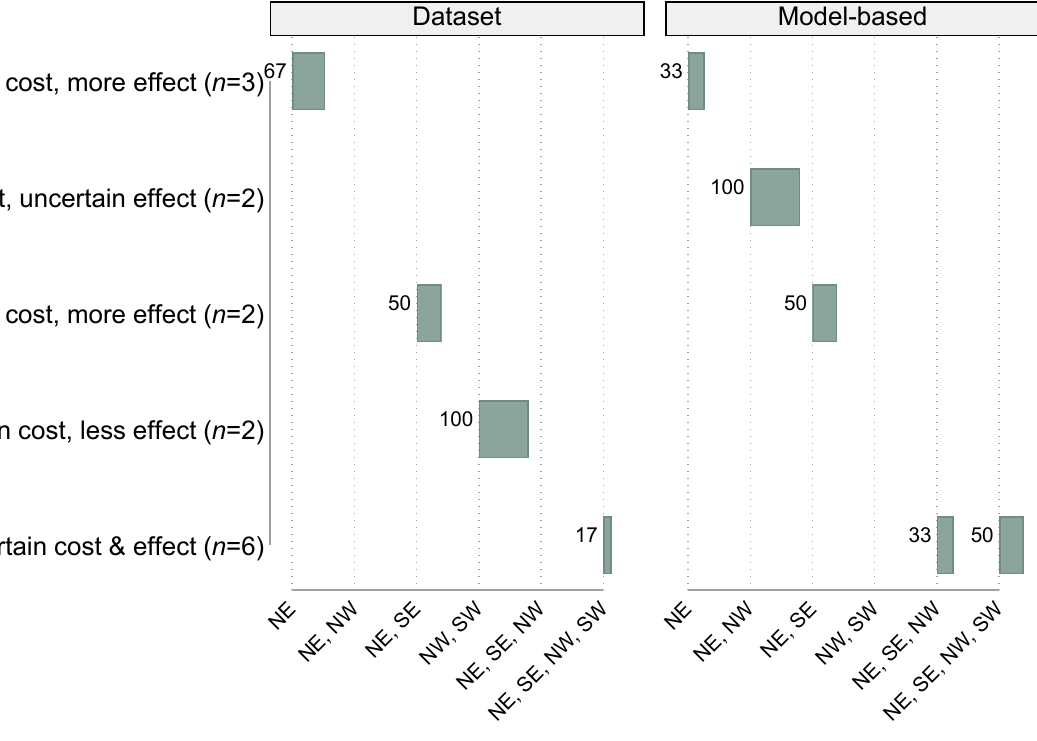
Figure 7. Location of uncertainty findings in scatterplots. Note: Location and meaning of uncertainty findings in scatterplots. The horizontal axis indicates location of the uncertainty in a cost-effectiveness plane and the vertical axis indicates the interpretation of the uncertainty. The numbers to the left of the “bars” are the row percentages across all (both dataset- and model-based analyses) papers. The quadrant interpretations are as follows: North-East (NE): higher cost, higher effect; NE, North-West (NW): higher cost, uncertain effect; NE, South-East (SE): higher effect, uncertain cost; NW, South-West (SW): lower effect, uncertain cost; NE, SE, NW: uncertain cost, uncertain effect; NE, SE, NW, SW: uncertain cost, uncertain effect.